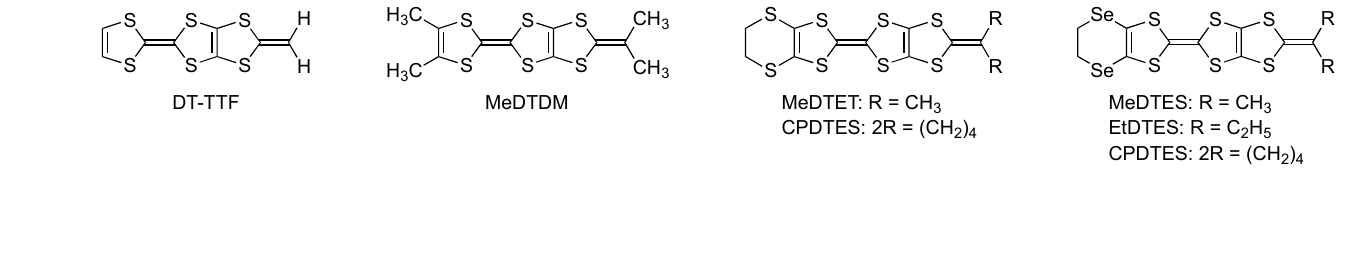
Figure 1. Molecular structures of TTF derivatives condensed with 2-alkylidene-1,3- dithiole unit